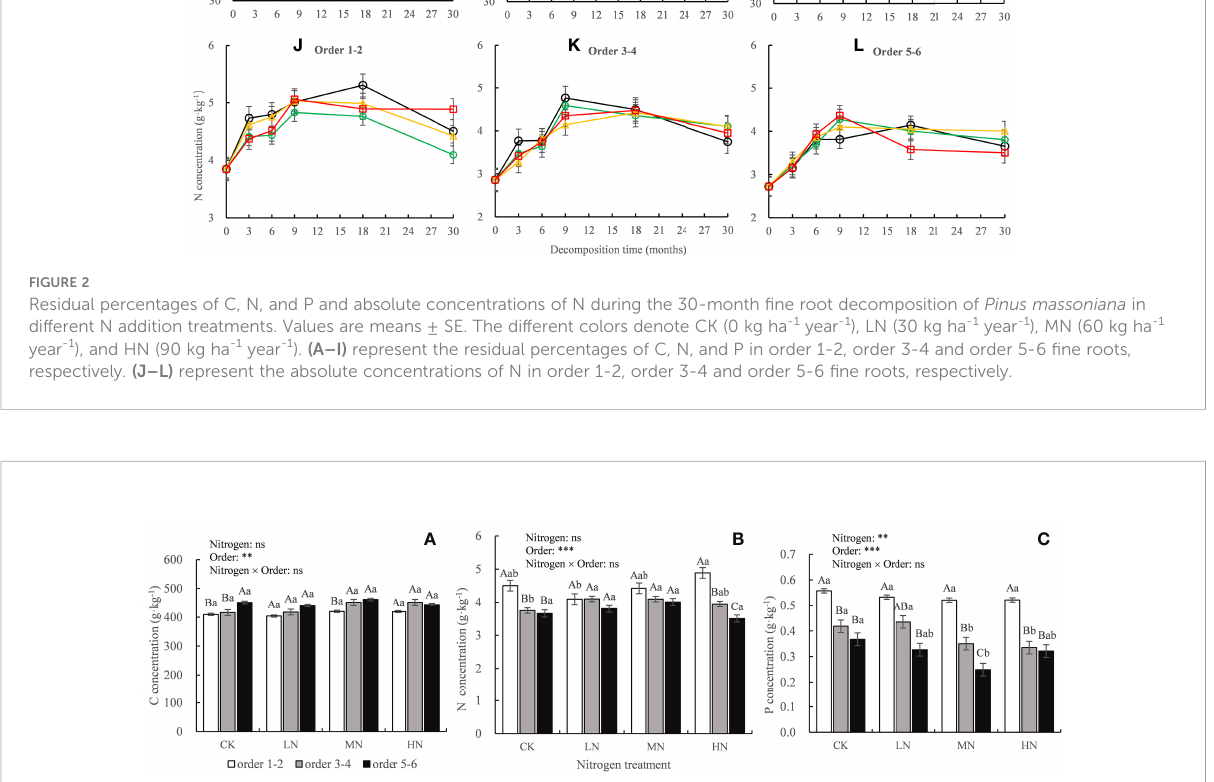
FIGURE 3 Absolute concentrations of C, N, and P in the decomposing roots in each treatment after 30 months of decomposition. Different capital letters indicate signi fi cant differences among different root orders under the same N addition treatment, and different lowercase letters indicate signi fi cant differences among the N addition treatments under the same root order ( P < 0.05). ** P < 0.01, *** P < 0.001, ns, no signi fi cant. CK: 0 kg ha -1 year -1 ; LN: 30 kg ha -1 year -1 ; MN: 60 kg ha -1 year -1 ; HN: 90 kg ha -1 year -1 . (A – C) represent the absolute concentrations of C, N, and P in fi ne roots,